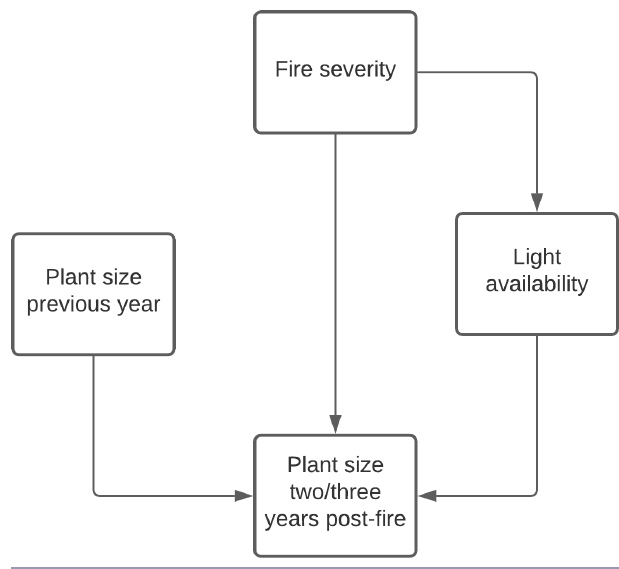
Fig. 1. Theoretical model to assess the relative strength of direct and indirect effects of fire on plant growth one to two and two to three years post-fire. All pathways are hypothesized as positive